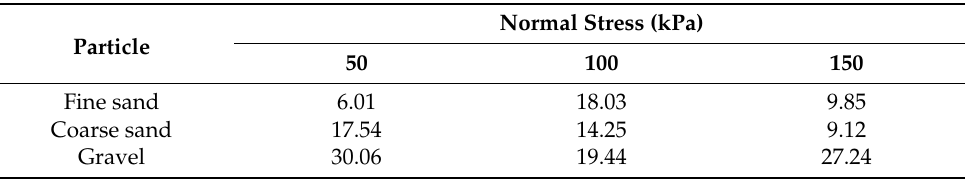
Table 4. Percentages of shear strength variation (%) for fine sand–triaxial geogrid, coarse sand–triaxial geogrid and gravel–triaxial geogrid